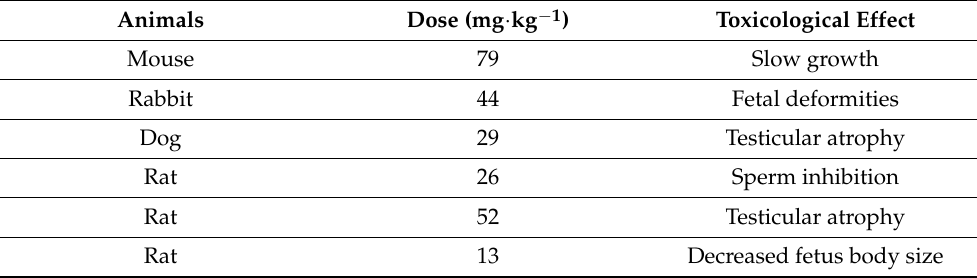
Table 4. The dose toxicological effect of boron on animals (Adapted with permission from Ref. [28]. 2018, Springer).